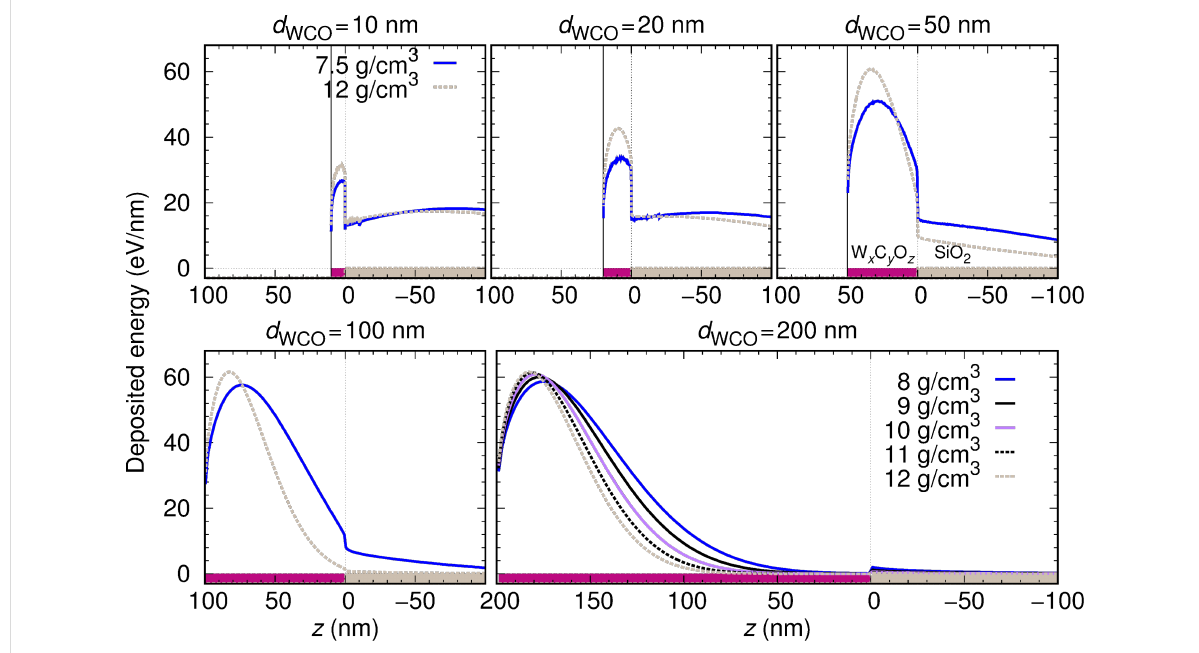
Figure 10: Same as Figure 7 for a fixed composition (27.5% W, 50.4% C, 22.1% O) and a variable density.